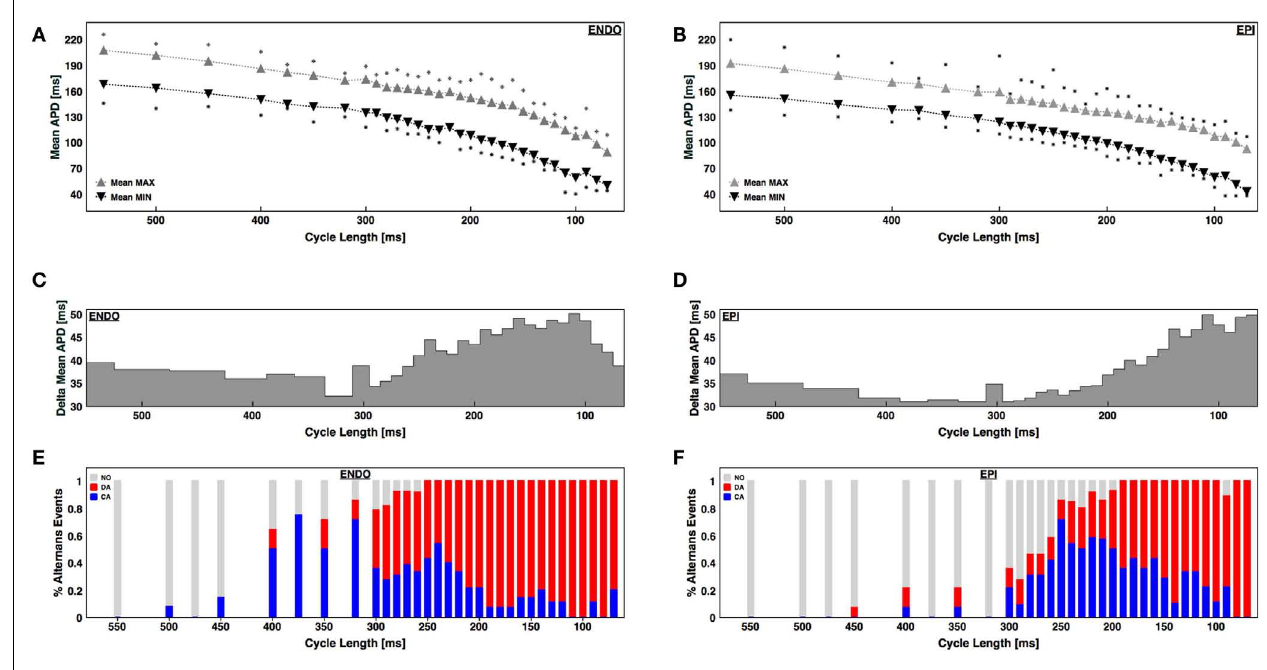
FIGURE 3 |APD dispersion and alternans development for the endocardium and epicardium. (A,B) Mean maximum APD (gray triangles) and mean minimum APD (black triangles) within the tissue for each CL for (A) endocardium and (B) epicardium.The squares indicate the maximum and minimum APDs from all preparations.